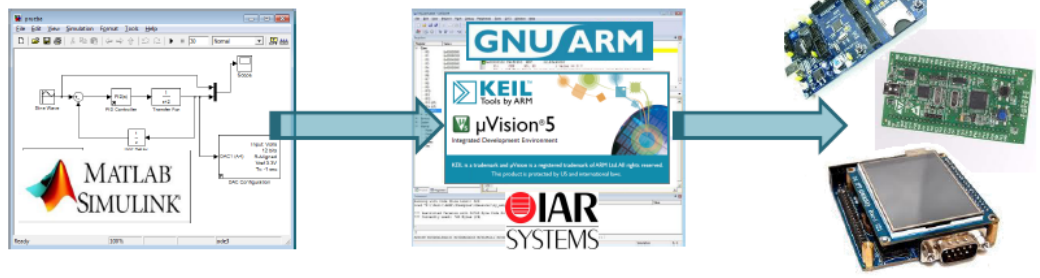
Figure 4. The Simulink R (cid:13) modeling workflow using the University Carlos III of Madrid (UC3M) rapid control prototyping (RCP) system. From left to right, Simulink generates